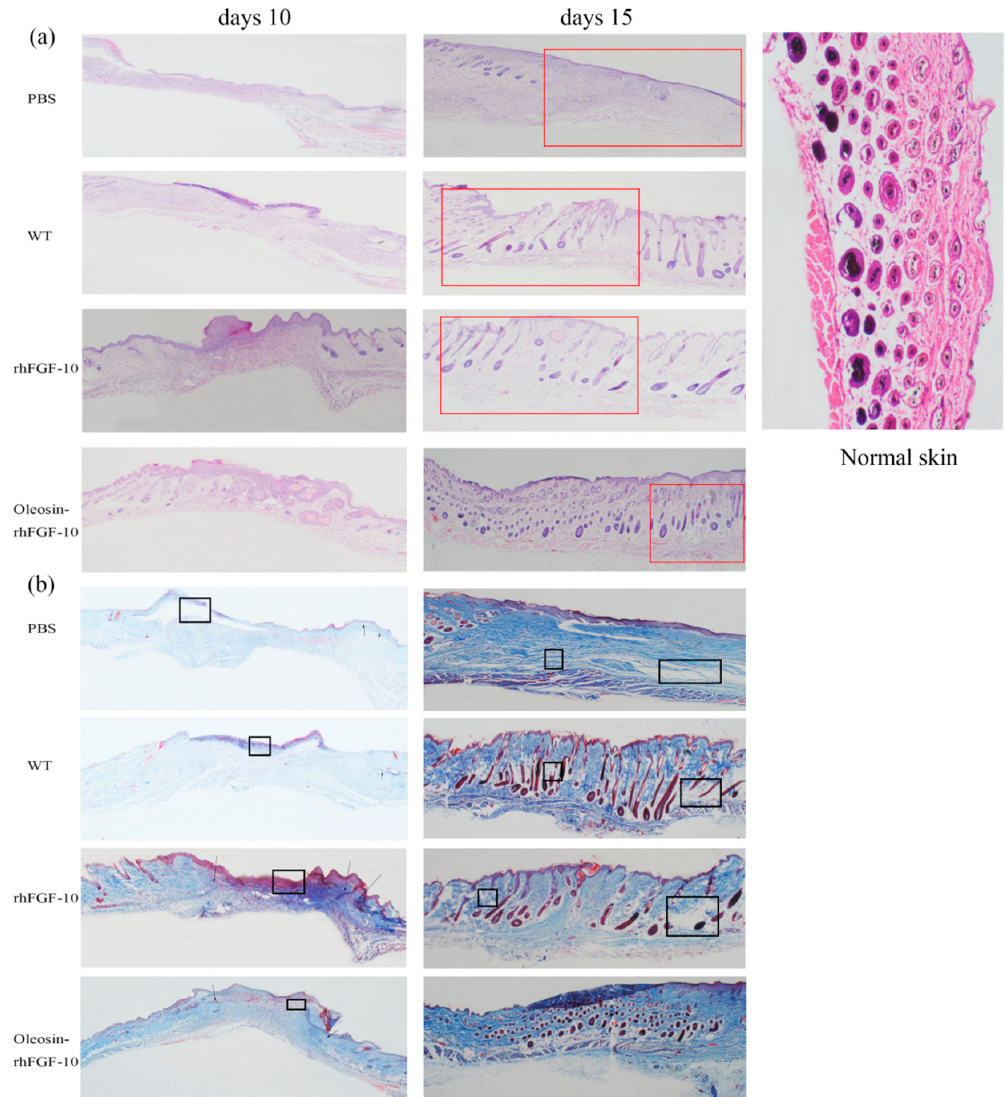
Figure 5. ( a ) Histological analysis of wound sites. Sections of wound skin at two time points following four treatments were stained with hematoxylin and eosin. The images are shown at 40× magnification; ( b ) collagen deposition in wound sites. Sections of wound skin at two time points following four treatments were stained with Masson’s trichrome. The unrepaired parts were marked by the black boxes and repair parts are marked by the arrows. The wound areas were marked by red boxes. The images are shown at 40× magnification.